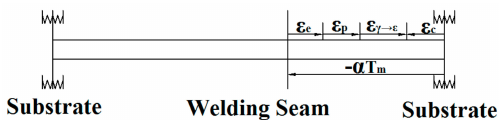
Figure 10. One-dimensional simplified model of laser